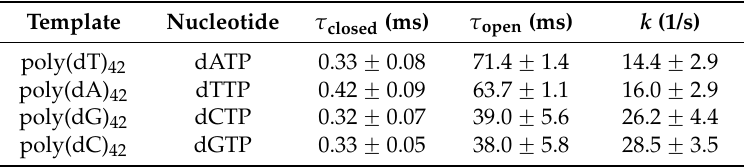
Figure 5. Example distributions of ( a ) τ open and ( b ) τ closed acquired for all four native nucleotides using a single KF molecule. The different slopes for τ open represent different average processing rates for the four nucleotides. The portion of the cycle represented by τ closed , in which catalytic incorporation of the nucleotide occurs, is insensitive to the nucleotide species. The exact value of < τ open > varies from one molecule to another and can be 50% to 300% of the values shown here. However, each different copy of KF follows the trends shown here. Table 1. Single-nucleotide processing rates with homopolymeric templates 1 .